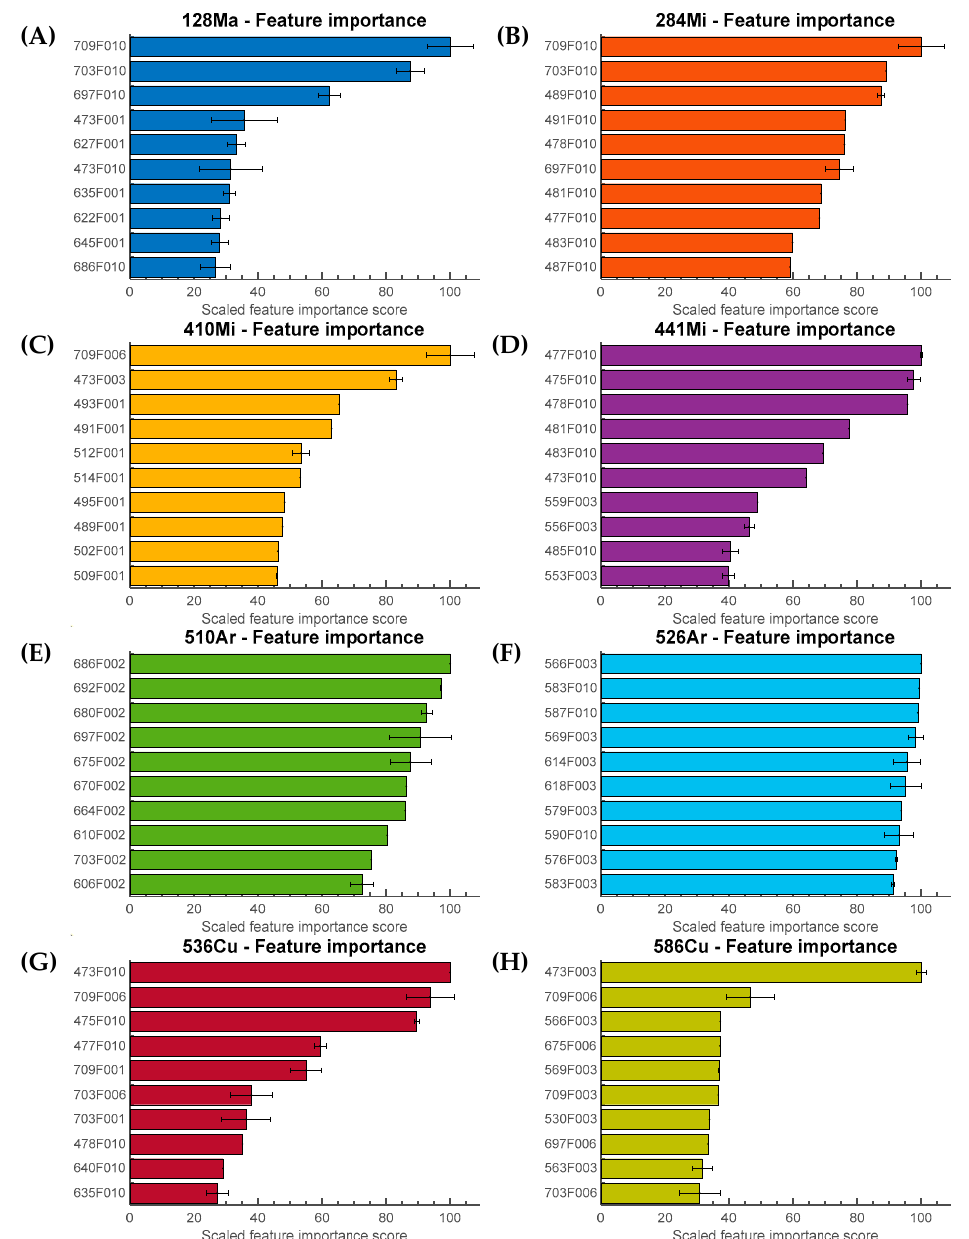
Figure 8. Top 10 predictive features and the normalized feature importance values for individ- ual organisms are presented: ( A ) 128- Massilia , ( B ) 284- Microbacterium , ( C ) 410- Microbacterium , ( D ) 441- Microbacterium , ( E ) 510- Arthrobacter , ( F ) 526- Arthrobacter , ( G ) 536- Curtobacterium , and ( H ) 586- Curtobacterium . The most predictive features for each organism were identified by the ENET regression model coefficients. The feature importance was scaled based on the feature with the highest absolute coefficient value. The result is an average of 10 repetitions, and the error bar represents the standard deviation. The feature names are defined by their wavelength followed by ”F” and the index position of the corresponding